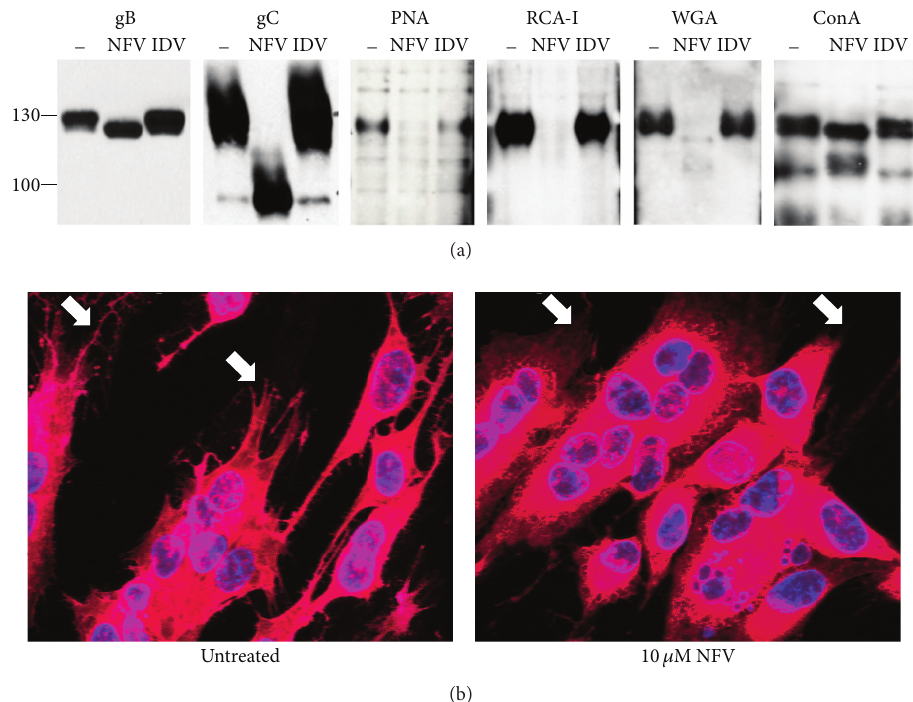
Figure 5: NFV affects the glycosylation and subcellular localization of viral gene products but does not change the level of expression. (a) Western blots of HSV-1 infected HF cells show increased mobility in gB and gC with NFV treatment, compared to cells that were untreated or treated with indinavir (IDV). Eastern blots show that altered staining by lectins (peanut agglutinin, PNA; ricinus communis agglutinin I, RCA-I; wheat germ agglutinin, WGA; and concanavalin A, ConA) demonstrates reduced overall glycosylation in NFV-treated cells. (b) HSV- 1 gB localization (red staining) is altered in NFV-treated HF cells, showing decreased delineation of plasma membrane processes (indicated by white arrows) by IFA compared to untreated cells. Nuclei are stained